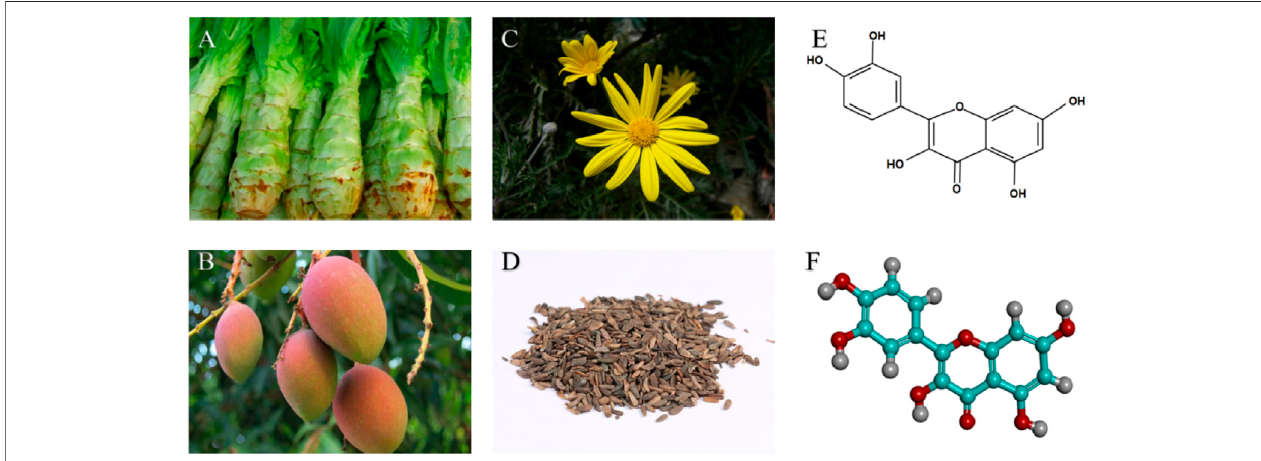
FIGURE 1 | Natural sources and structures of quercetin: (A) Lettuce Rootstock; (B) Mango fruit; (C) Arnica fl owering plants; (D) Dried ripe fruit of burdock; (E) Chemical structure of quercetin; (F) 3D structure of quercetin (Visualized by DiscoveryStudio